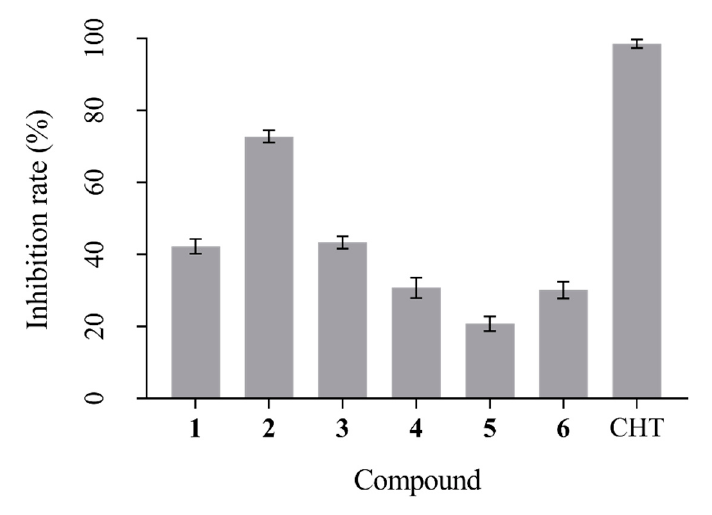
Figure 4. The inhibitory effect of tested compounds on B. maydis at 100 µ g/mL with chlorothalonil (CHT) as positive control. Table 3. Half maximal effective concentration (EC 50 ) values of compounds 1 – 6 on B. maydis